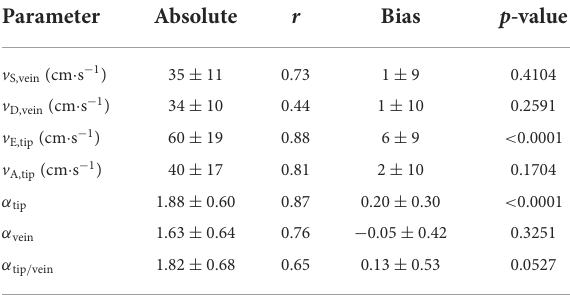
Absolute values and bias to the corresponding quantity determined at the atrial junction of the pulmonary vein and/or the atrio-ventricular junction are given as means ± standard deviations. r is the correlation coefficient between corresponding parameters determinedatdifferentlocations.p-valuereferstothesignificancetestofthebias.v S , vein , systolic peak velocity determined in the pulmonary vein; v D , vein , diastolic peak velocity determined in the pulmonary vein; v E , tip , early diastolic peak velocity determined at